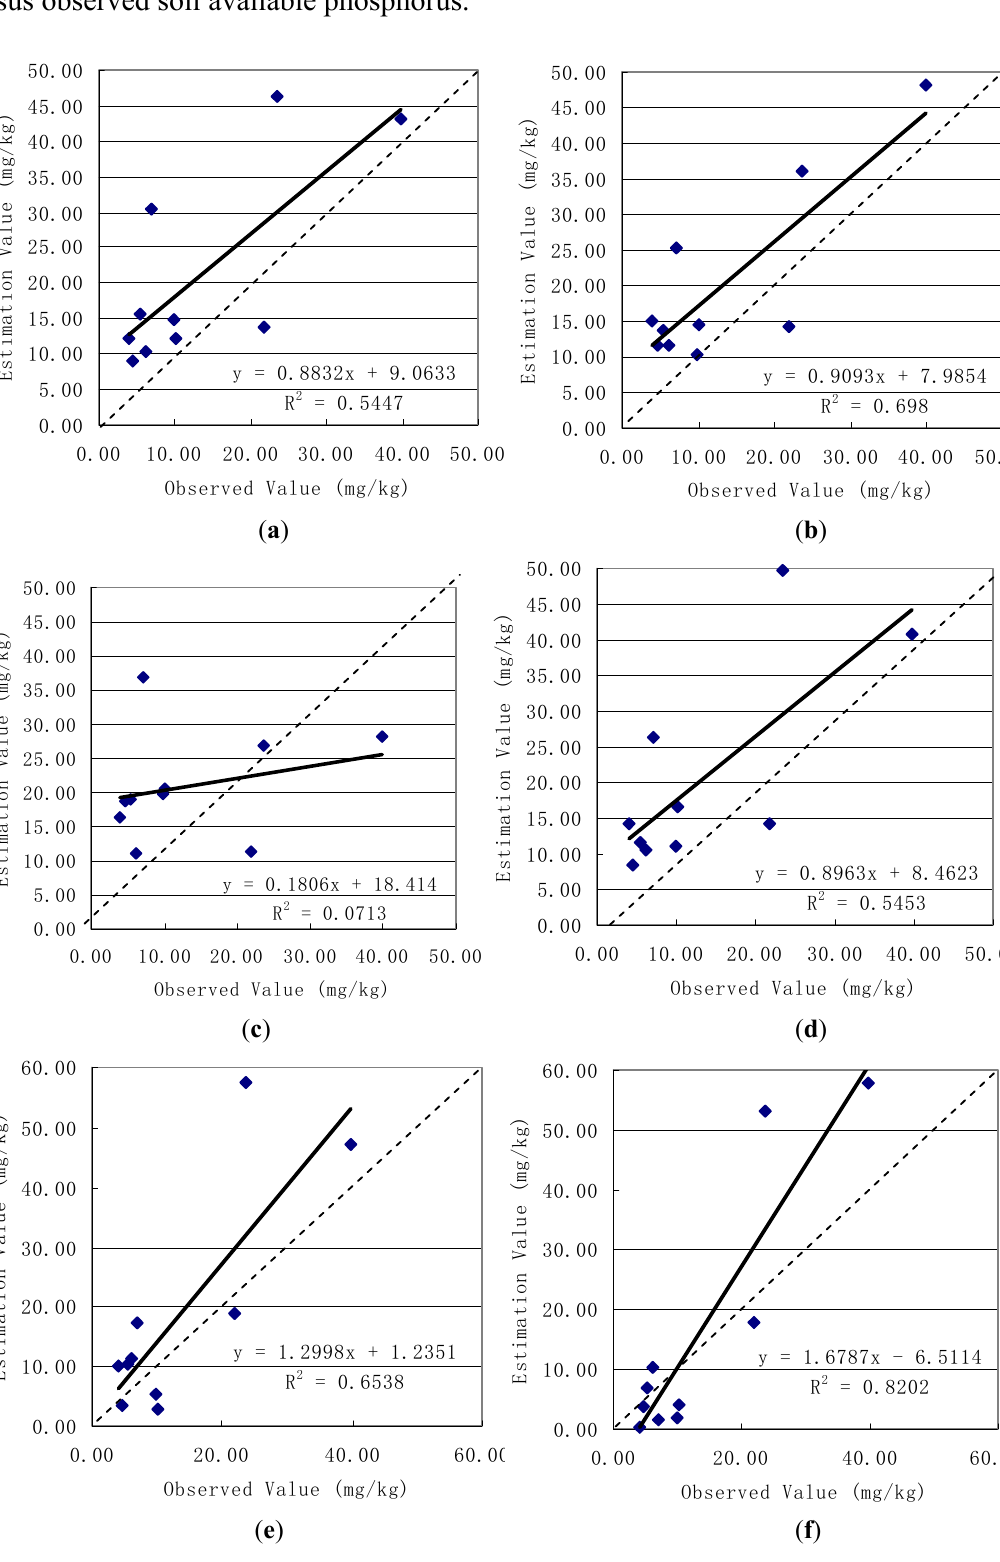
Figure 3. Predicted using ( a ) Kriging Ordinary Exponential ( b ) Kriging Ordinary Gaussian ( c ) Kriging Ordinary Spherical ( d ) IDW ( e ) Spline Regularized ( f ) Spline Tension methods versus observed soil available phosphorus.